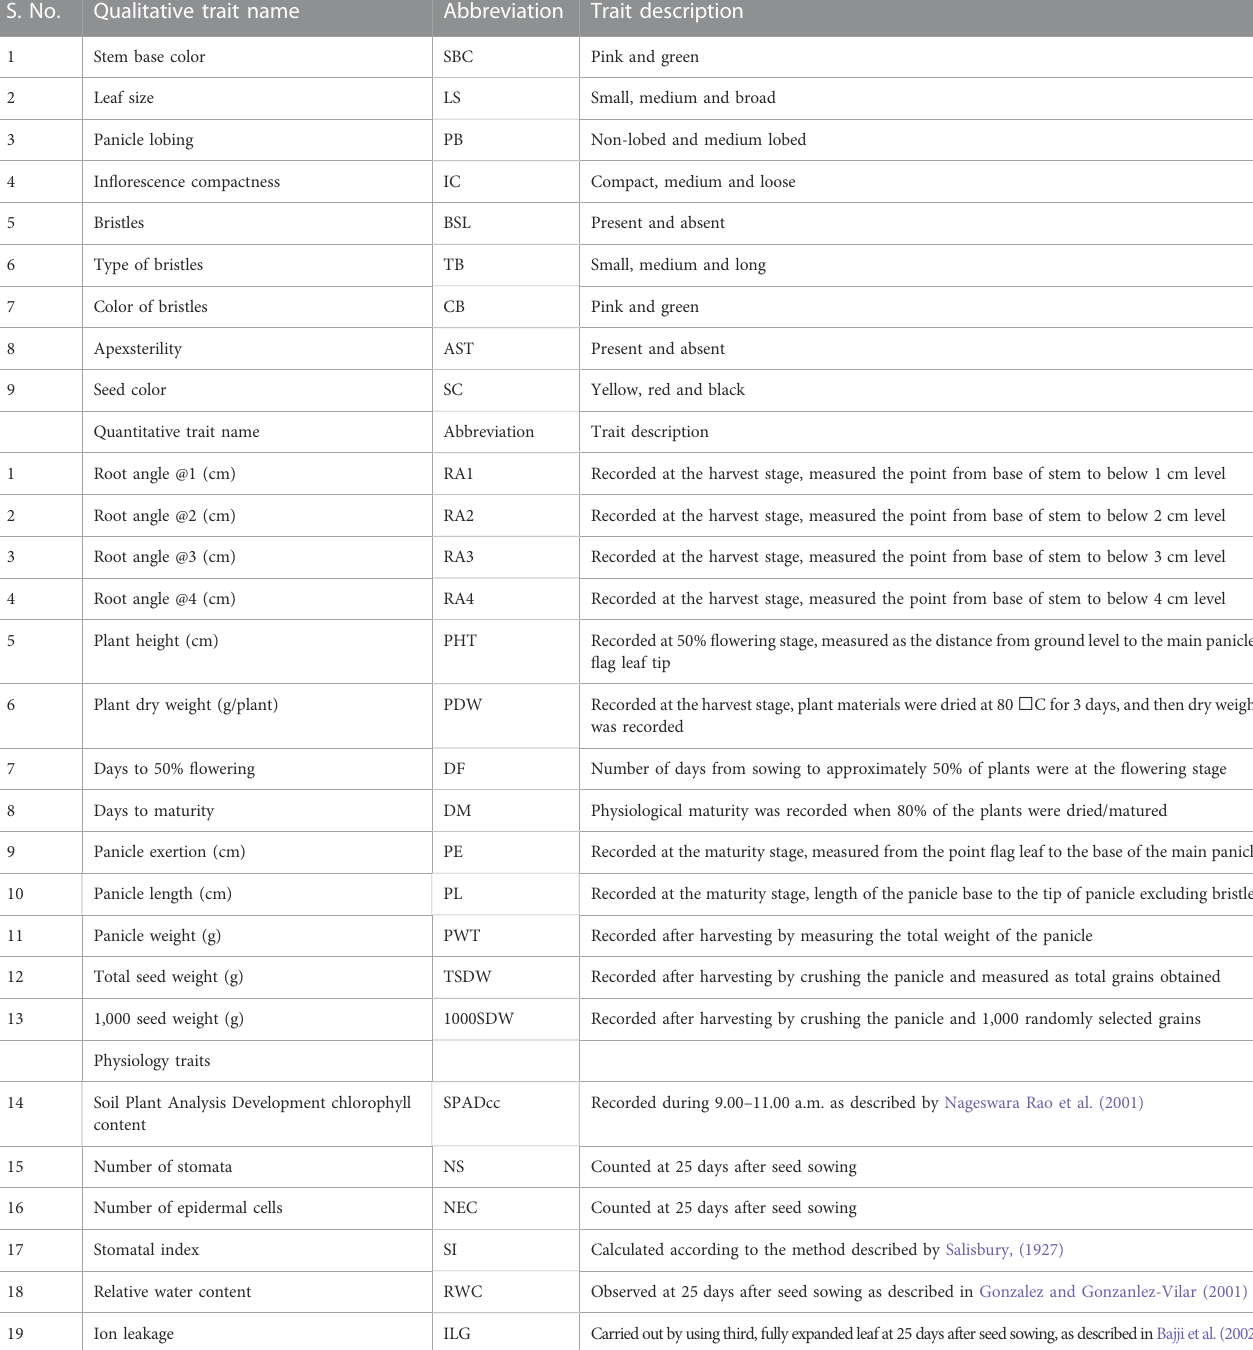
TABLE 1 List of the 28 morpho-physiological, yield and yield related traits used in the study. S.